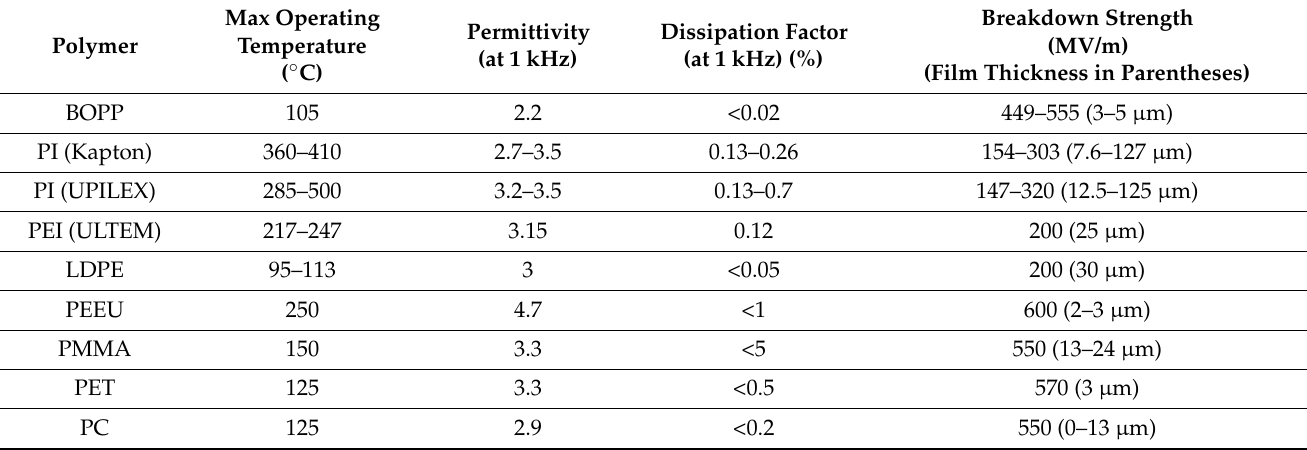
Table 1. Summary of basic properties of several linear dielectric